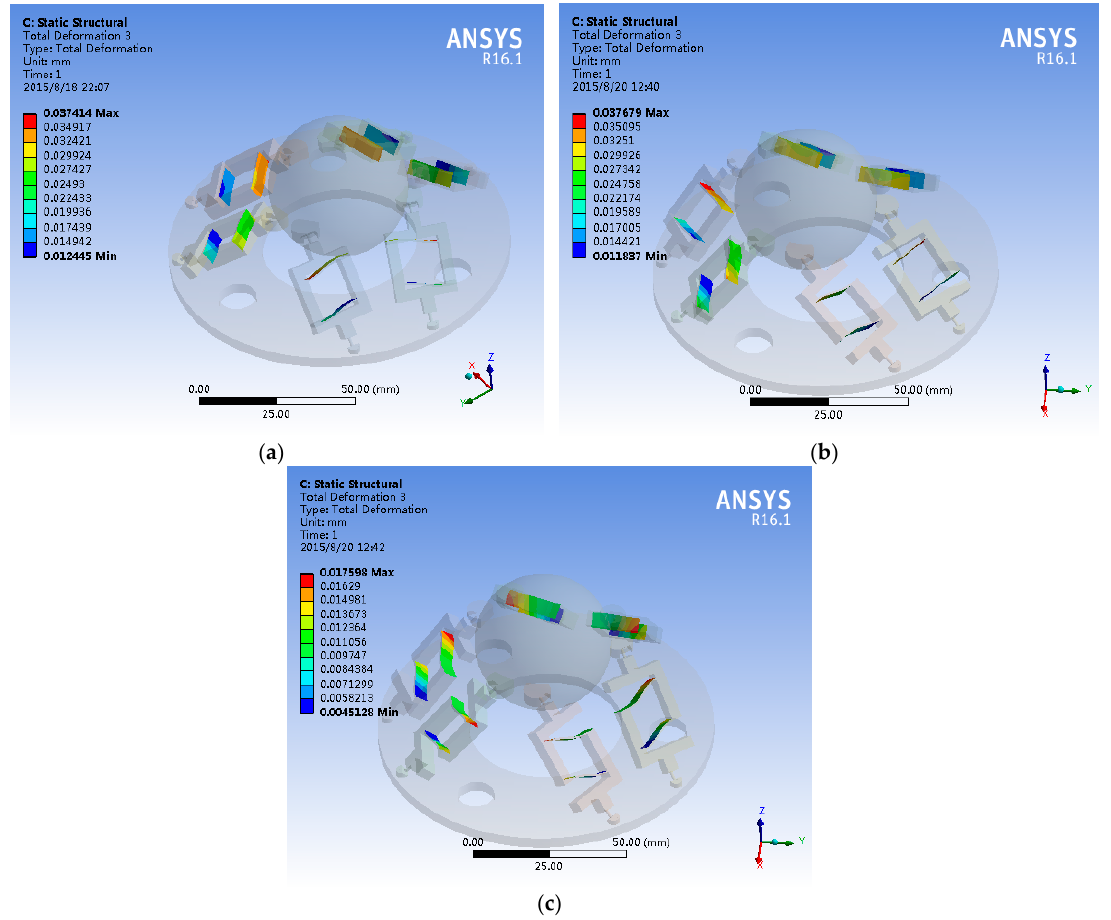
Figure 5. Deformation of the six beams in ANSYS Workbench: ( a ) deformation under a load g x on the moving platform in ANSYS Workbench; ( b ) deformation under a load g y on the moving platform in ANSYS Workbench; and ( c ) deformation under a load g z on the moving platform in ANSYS Workbench.